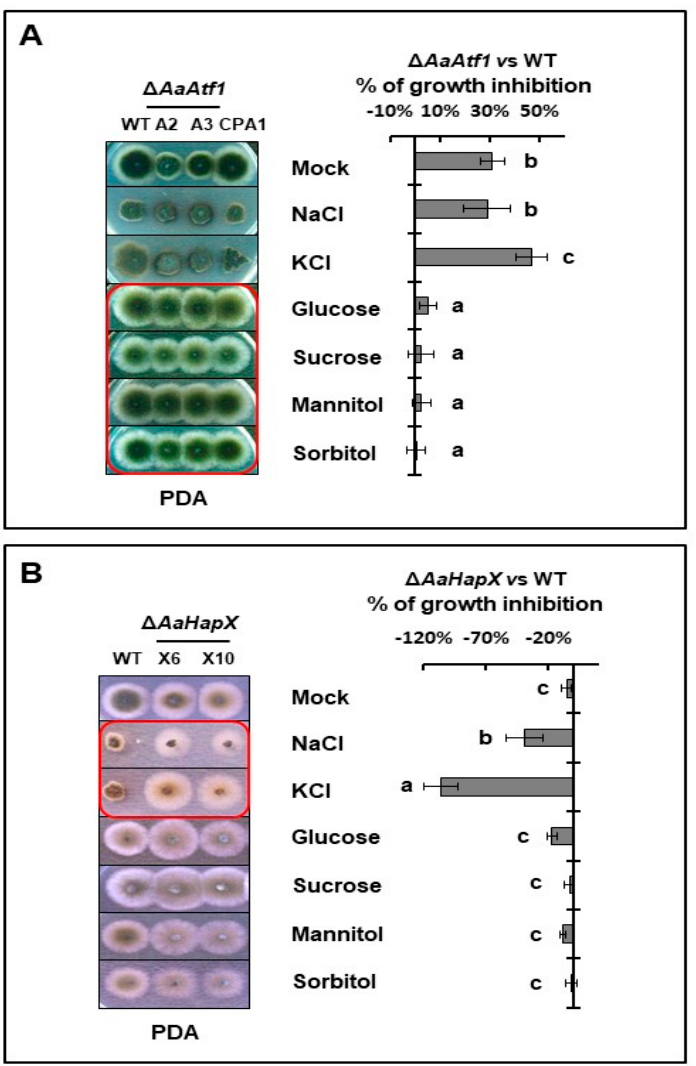
Figure 6. AaAtf1 and AaHapX play different roles in stress resistance. ( A ) Sensitivity tests assayed on PDA revealed that, compared to wild type, ∆ AaAtf1 increased resistance to glucose, sucrose, mannitol, and sorbitol. ( B ) ∆ AaHapX increased resistance to KCl and NaCl. The percent of growth inhibition (%) is shown on the right side. Means indicated by the same letter are not significantly different, p < 0.05. All experiments were repeated at least two times, showing similar trends.